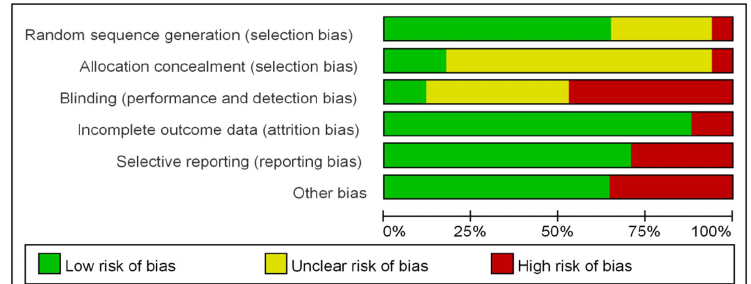
Figure 2. Risk of bias graph. Review author’s judgment about each risk of bias item presented as percentage across studies.